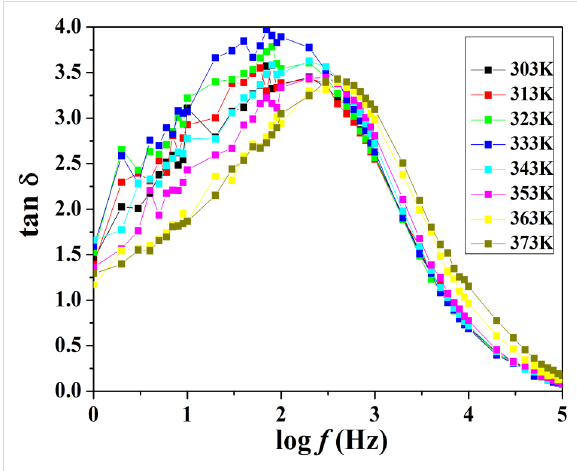
Figure 9: Variation of the loss tangent (tan δ ) as a function of frequen- cy at different temperatures.